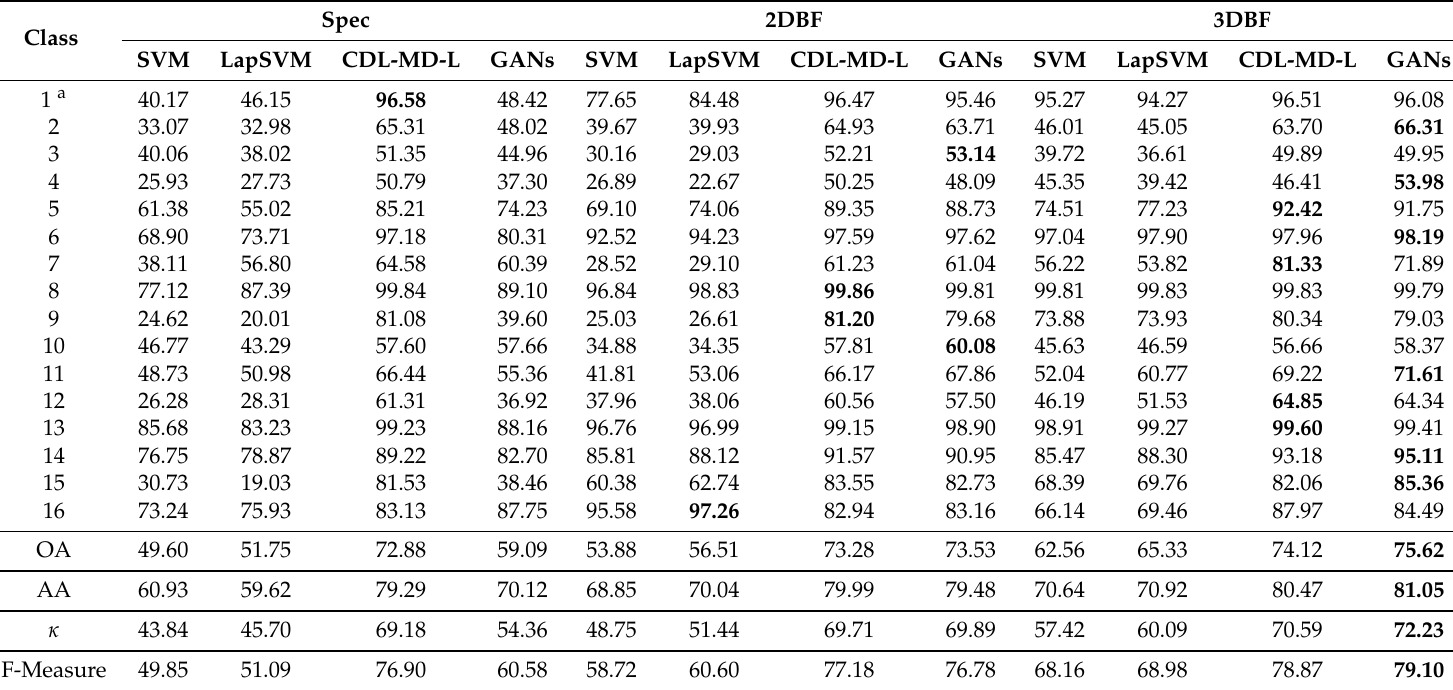
Table 4. Classification accuracy (%) of various methods for the Indian Pines data with 5 labeled training samples per class, bold values indicate the best result for a